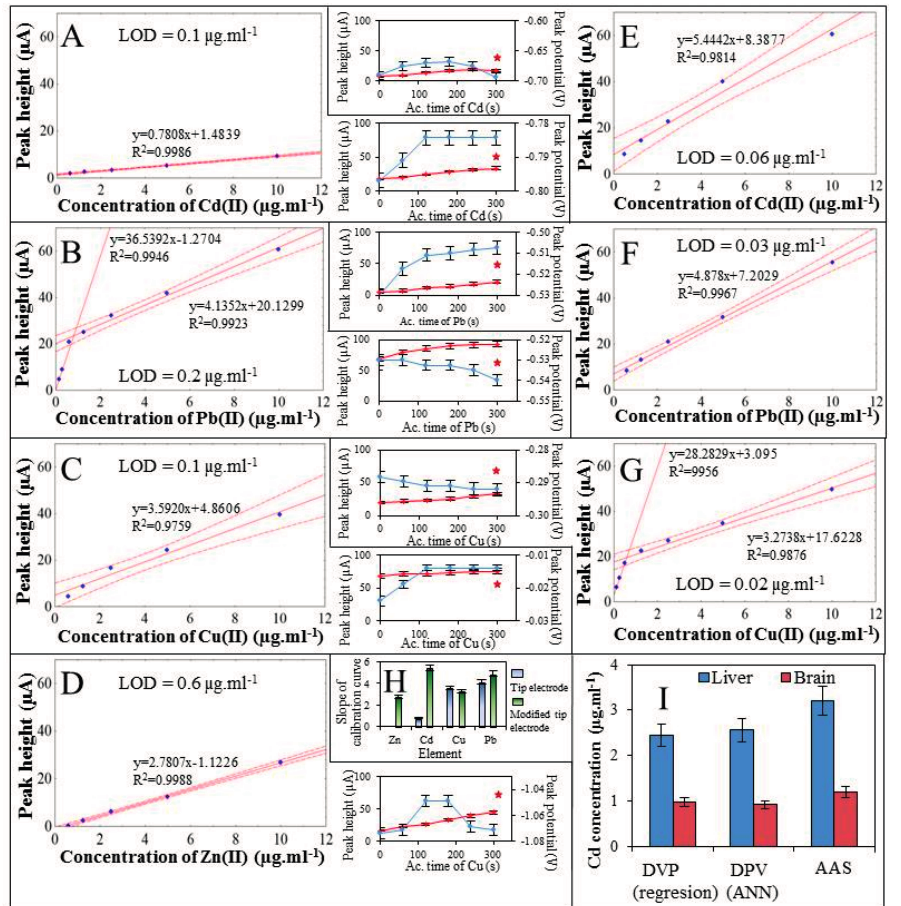
Figure 2. Calibration curves of ( A ) cadmium(II) (0.6–10 µg·mL − 1 ); ( B ) lead(II) (0.16–10 µg·mL − 1 ) and ( C ) copper(II) ions (0.6–10 µg·mL − 1 ) measured using carbon tip electrode. Calibration curves of ( D ) zinc(II); ( E ) cadmium(II); ( F ) lead(II) (all 0.6–10 µg·mL − 1 ) and ( G ) copper(II) ions (0.16–10 µg·mL − 1 ) measured using thin film mercury electrode. ( H ) The graph of optimized time of accumulation (0–300 s) ( red line ) is connected with appropriate calibration curve and shows the changes of peak potential ( blue line